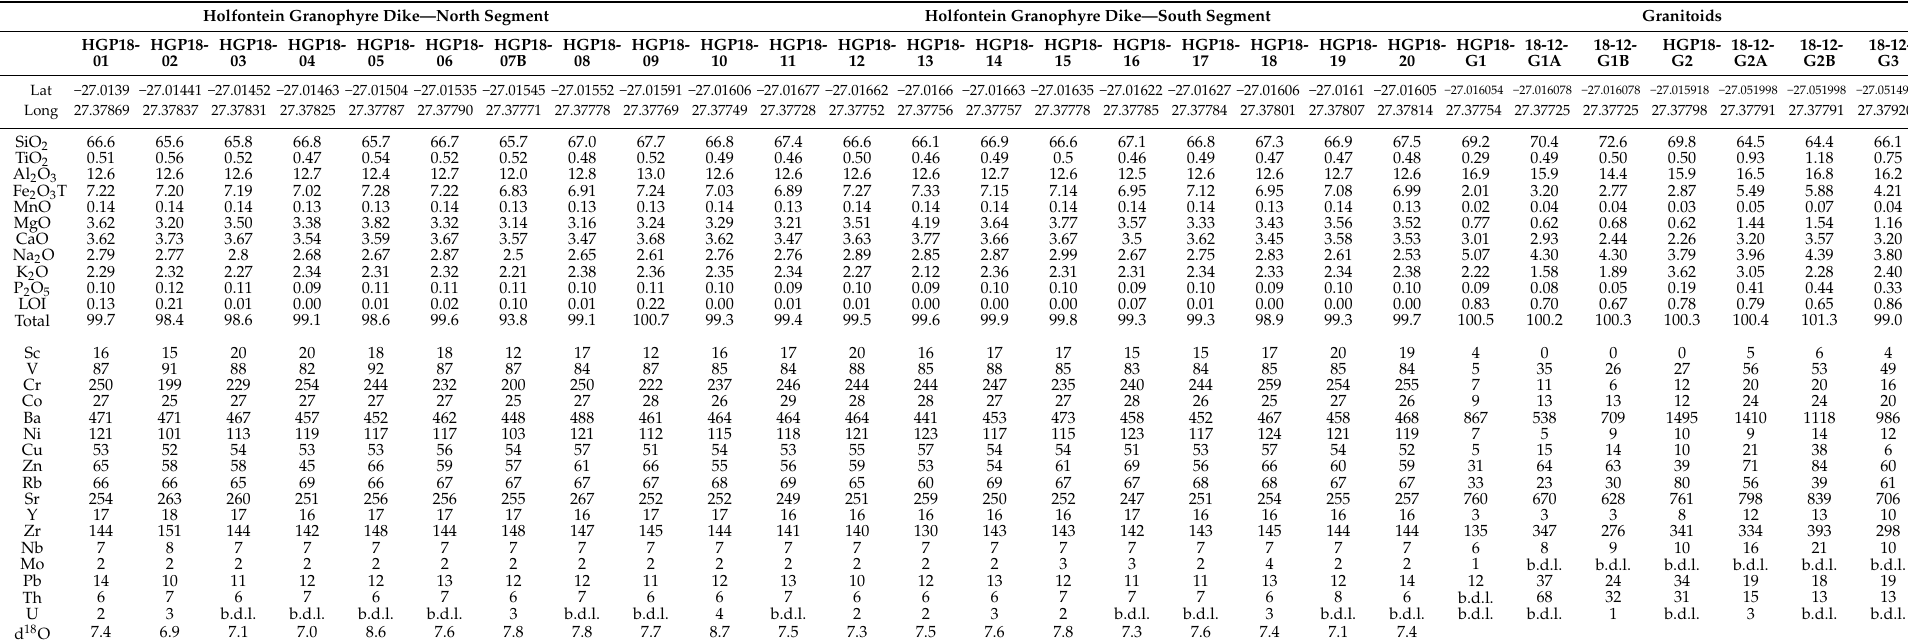
Table 1. Major (wt.%) and trace (ppm) element data for granophyre and granitoid samples.